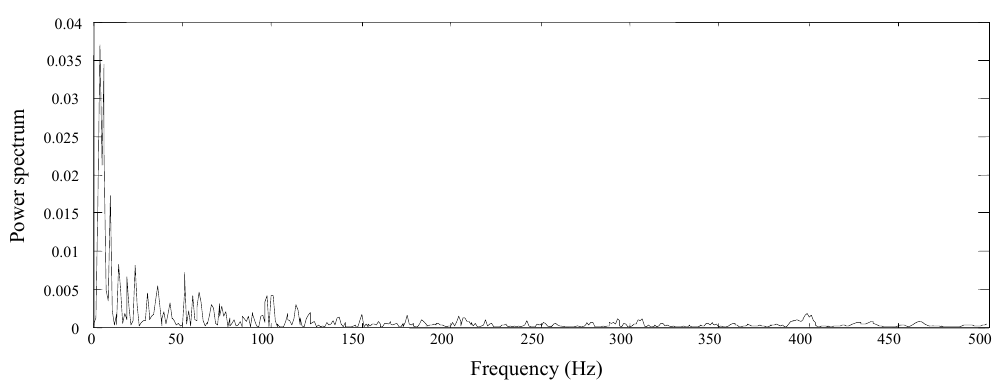
Fig. 11. Synthesized seismic acceleration time-history (site = type IV).